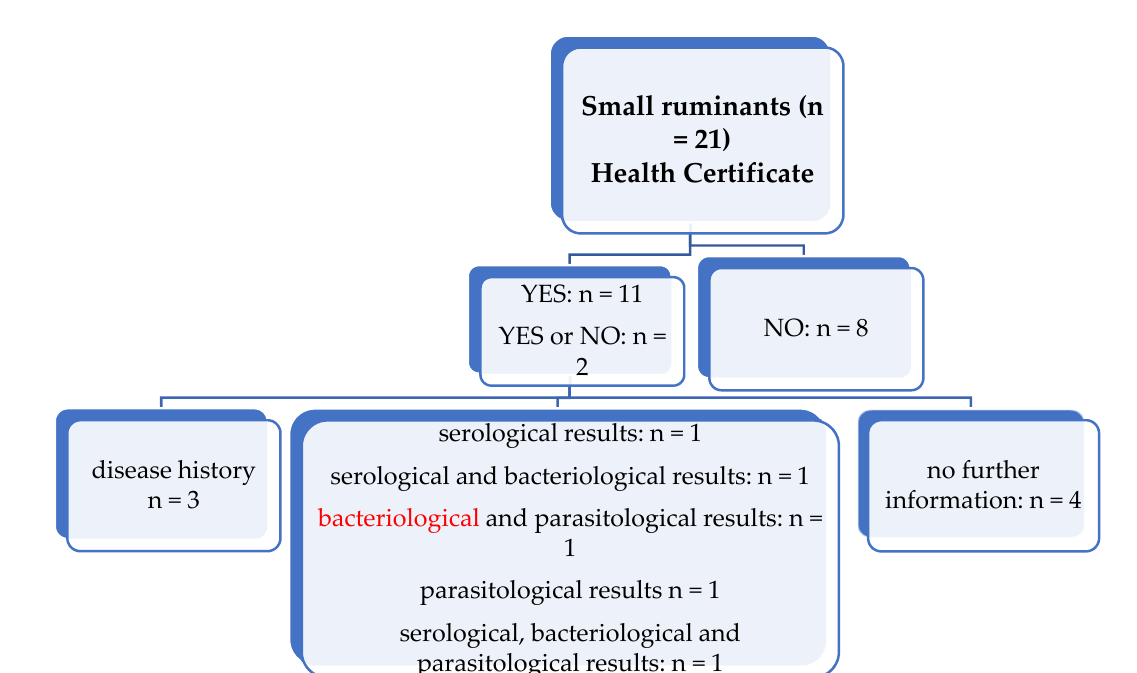
Figure 4. Overview of whether small ruminants were purchased with or without a health certificate and which information was provided in the health certificate. Two participants did not answer the question. n = number of responding participants; yes/no: Testing was/was not performed.